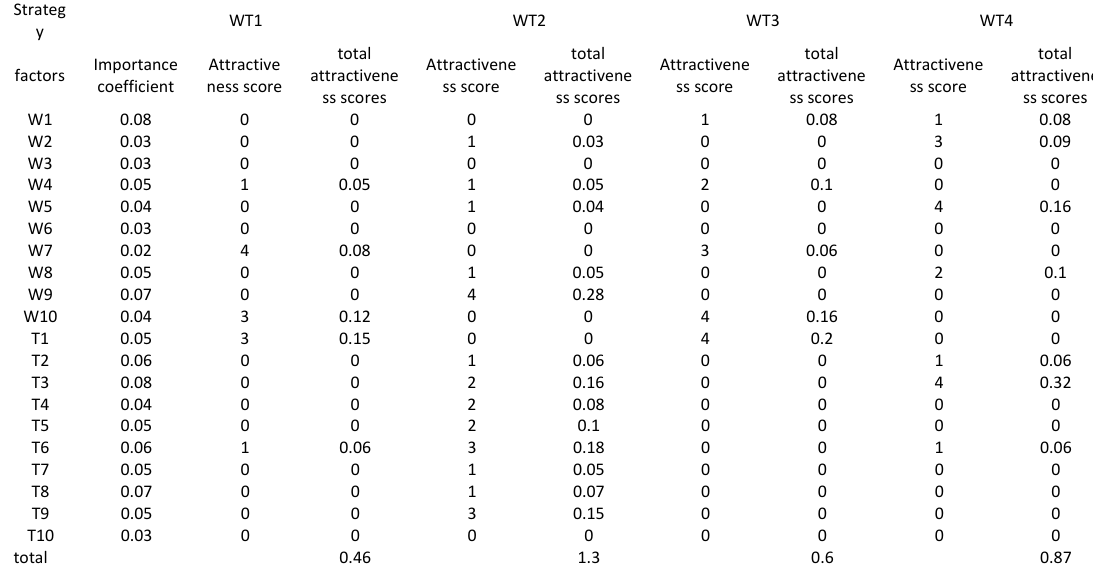
Table 8: QSPM of WT